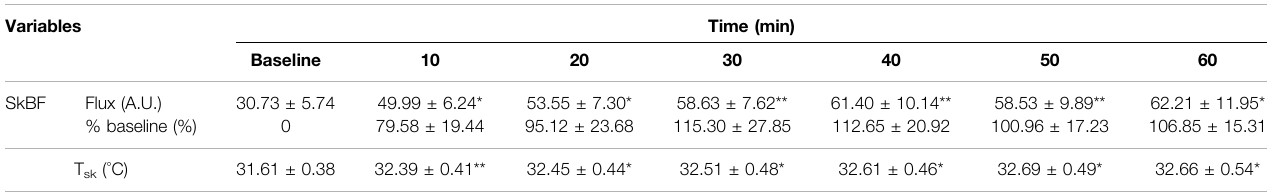
TABLE 1 | Skin blood fl ux (SkBF) and skin temperature (T sk ) in response to cutaneous application of analgesic cream from pilot study. Variables